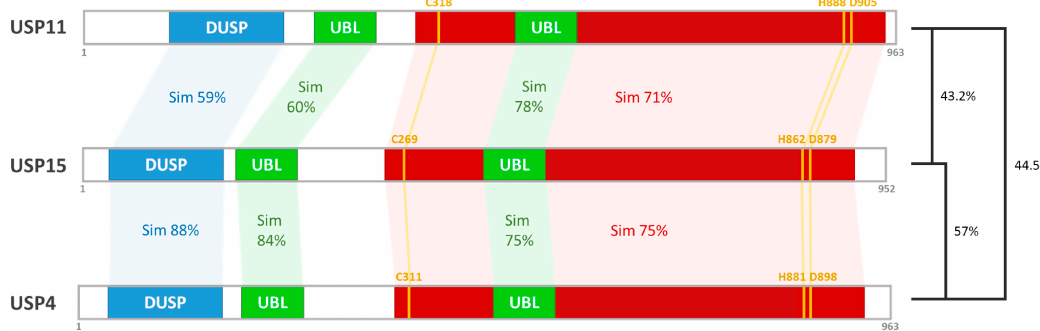
Figure 2. Alignments of USP15 and its paralogs USP4 and USP11. Paralogs of USP15, USP4 (NP_003354.2), and USP11 (NP_004642.2), show high similarity and identity in domain structure with USP15 proteins. Overall, USP15 shares 57% identity with USP4, and 43.2% identity with USP11. DUSP, domain present in ubiquitin-specific proteases; UBL, ubiquitin-like fold; red color represents USP catalytic domain; Sim, protein sequence similarity.